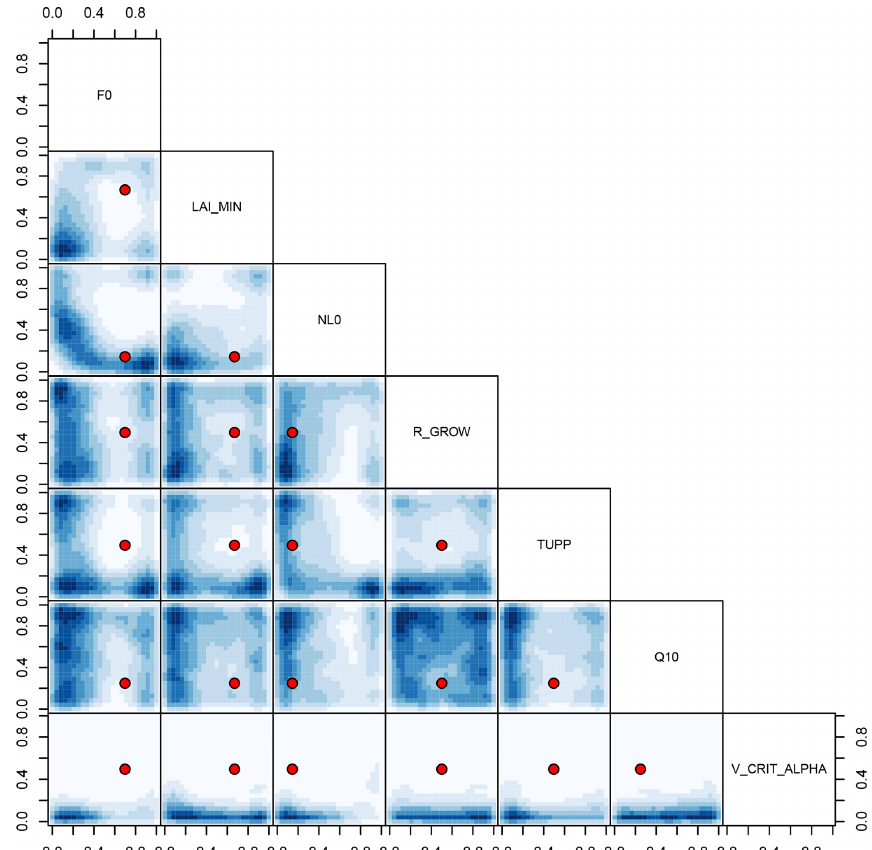
Figure 11. NROY land surface input space shared by all three forests before bias correction. Blue shading denotes the density of NROY input candidates, projected into the two-dimensional space indicated by the labels. The default parameter settings are marked as red